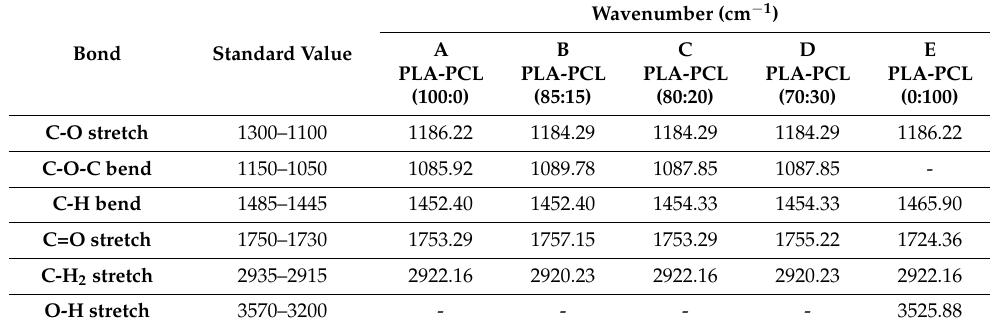
Figure 2. FTIR Spectrum of samples with composition of PLA:PCL; A (100:0), B (85:15), C (80:20), D (70:30), and E (0:100) in wt%.